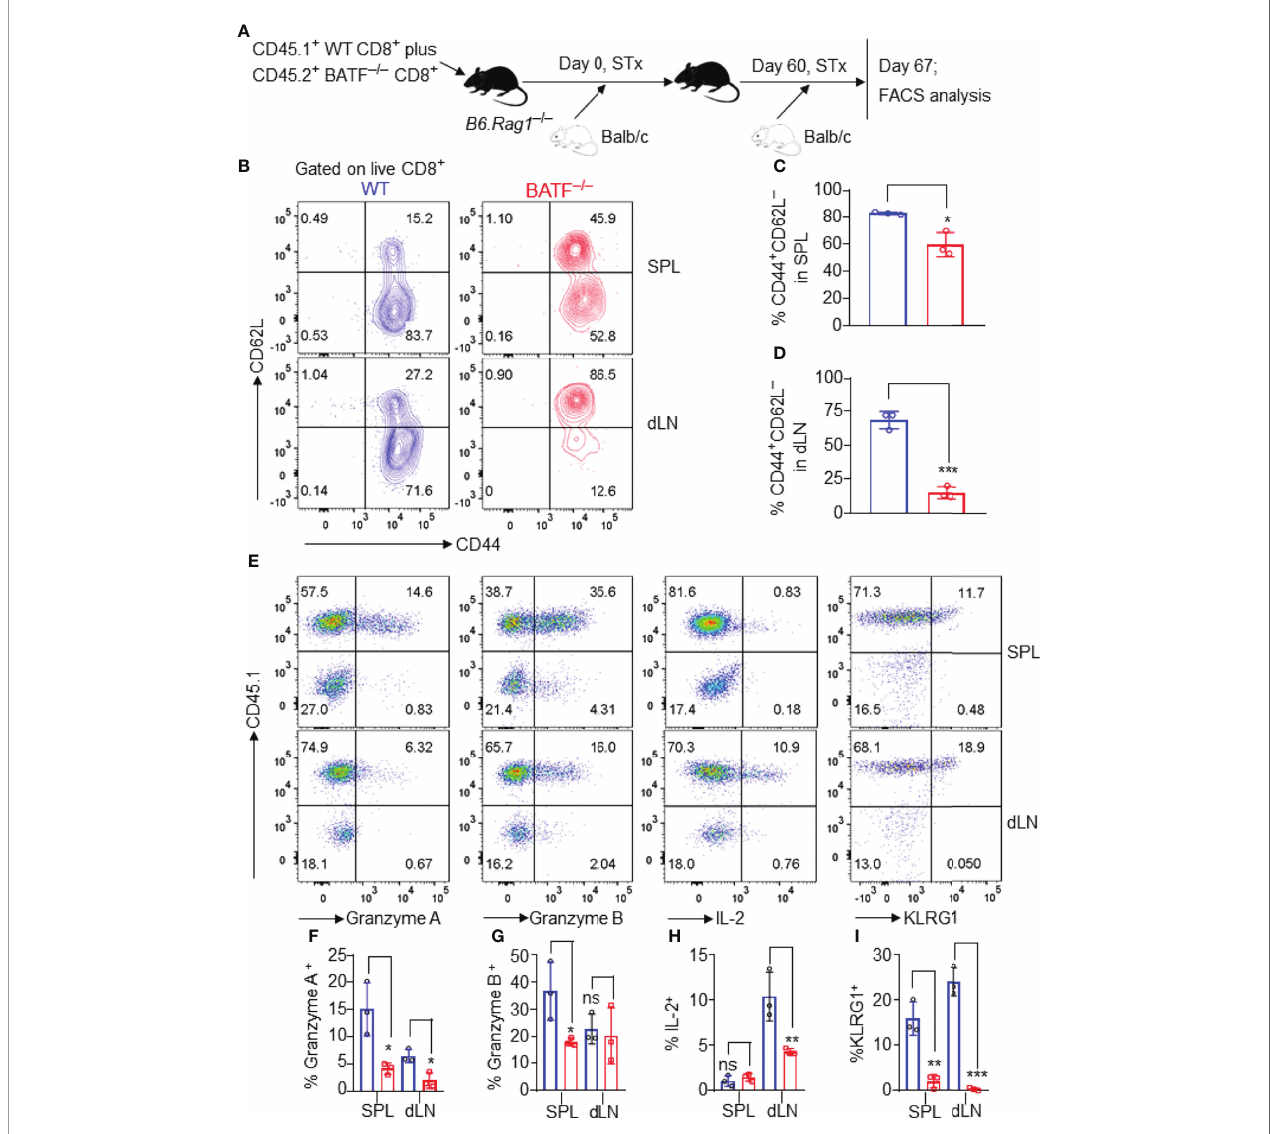
FIGURE 6 | BATF-de fi cient CD8 + T cells display impaired memory responses upon allogeneic antigen re-stimulation. B6. Rag1 – / – mice were reconstituted with a mixture of WT and BATF CD8 + T cells – / – (in a 1:1 ratio) on day -1, transplanted with Balb/c skins on day 0, and re-transplanted with Balb/c allografts on day 60 post-initial transplantation. On day 7 post-secondary transplantation, the cell states of the transferred CD8 + T cells were determined by fl ow cytometry. All the representative plots are gated on live CD8 + T cells. (A) Schematic of the experimental design. (B – D) Representative plots and bar graphs show % CD44 + CD62L – cells. (E – I) Representative plots and bar graphs display the expression of Granzyme A, Granzyme B, IL-2, and KLRG1. Data represent the mean ± SD (n = 3). ns, p > 0.05, * p < 0.05, ** p < 0.01, *** p < 0.001; (unpaired Student ’ s t